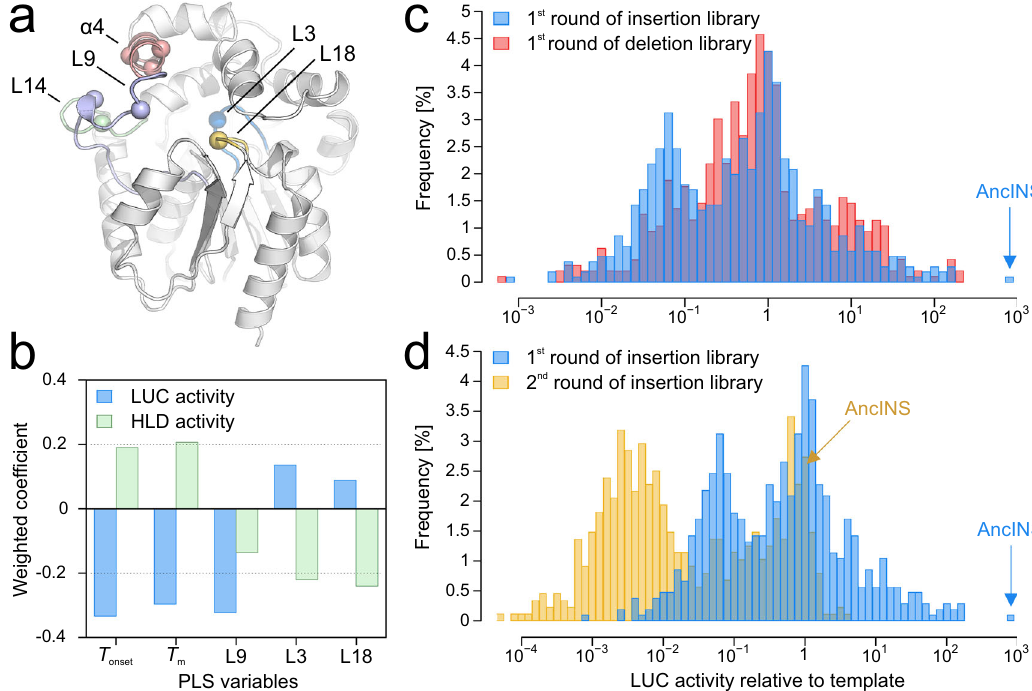
Fig. 2 Quantitative structure-function relationships and analysis of the effects of template and mutation type on activity. a Crystal structure of the thermostable Anc HLD-RLuc (PDB ID 6G75) showing the positions of the L9 loop (light blue), the α 4 helix (salmon) and the L14 loop (pale green), where InDels (spheres) resulted in an increase of luciferase (LUC) activity. Correlated motions of L3 (marine) and L18 (yellow) loops carrying two of the fi ve catalytic amino acids (spheres) were identi fi ed as signi fi cant contributors to dehalogenase (HLD) activity by the partial least squares (PLS) regression analysis. b Weighted coef fi cients quantifying contributions of variables indicated in the PLS models to explain the variance in HLD (green) and LUC (blue) activity. Note that different directionality of these coef fi cients for all variables, except loop L9, suggests different mechanistic and structural requirements for the two enzymatic functions studied. PLS generated models that explained substantial amounts of the variation in both LUC activity ( R 2 = 0.73, Q 2 = 0.67, n = 25 is the number of InDel variants) and HLD activity ( R 2 = 0.63, Q 2 = 0.54, n = 25 is the number of InDel variants). To obtain Q 2 the model was recalculated 999 times with a randomly re-ordered dependent variables. c Comparison of frequencies of variants with their activities relative to the ancestral protein in the fi rst-round insertion (R1I, blue) and deletion (R1D, red) libraries. The template for R1I and R1D was Anc HLD-RLuc . The best insertion variant AncINS is indicated by an arrow. d Comparison of frequencies of variants with indicated activities relative to their respective templates observed in the fi rst round of insertion library (R1I, blue) and the second round of insertion library (R2I, yellow). Note that the starting template Anc HLD-RLuc for R1I and R1D is less active than the starting template AncINS for R2I. The template for R2I was AncINS. Source data is available as a Source data fi le for Fig.